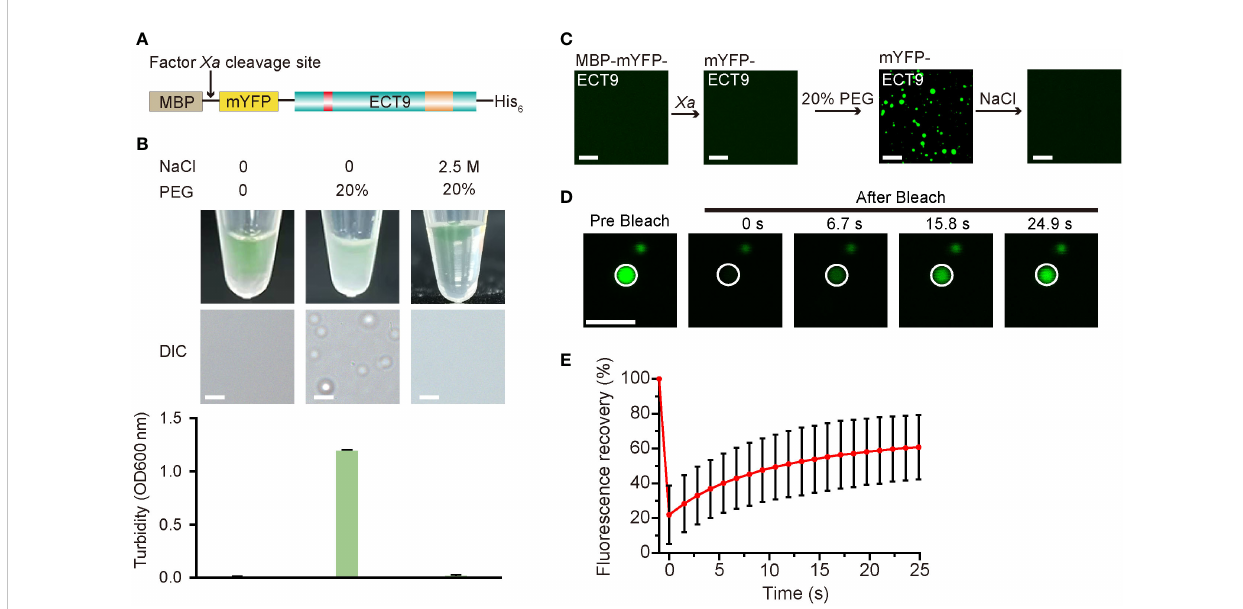
FIGURE 2 Full-length ECT9 undergoes phase separation in vitro . (A) Schematic of the full-length protein fusion used for in vitro phase separation assay. (B) Phase separation behaviors of puri fi ed mYFP-ECT9 (28 µM) in the presence of crowding agent PEG with or without 2.5 M NaCl by a white light photograph in tubes (top) and DIC microscopy observation for droplet formation (middle) and optical density measurement at 600 nm (OD 600 nm) of turbidity changes (bottom). Turbidity data are presented as means ± SD of OD 600 nm value (n = 4). Scale bar, 50 µm. (C) In vitro phase separation assay of mYFP-ECT9 by a confocal laser scanning microscopy photograph. Scale bar, 20 µm. (D) FRAP of mYFP-ECT9 condensates in vitro . Time 0 indicates the start of the photobleaching pulse. Scale bar, 1 µm. (E) A plot showing the time course of the fl uorescence recovery after photobleaching mYFP-ECT9 droplets. Mean ± SD (n = 8). Data are representative of three independent